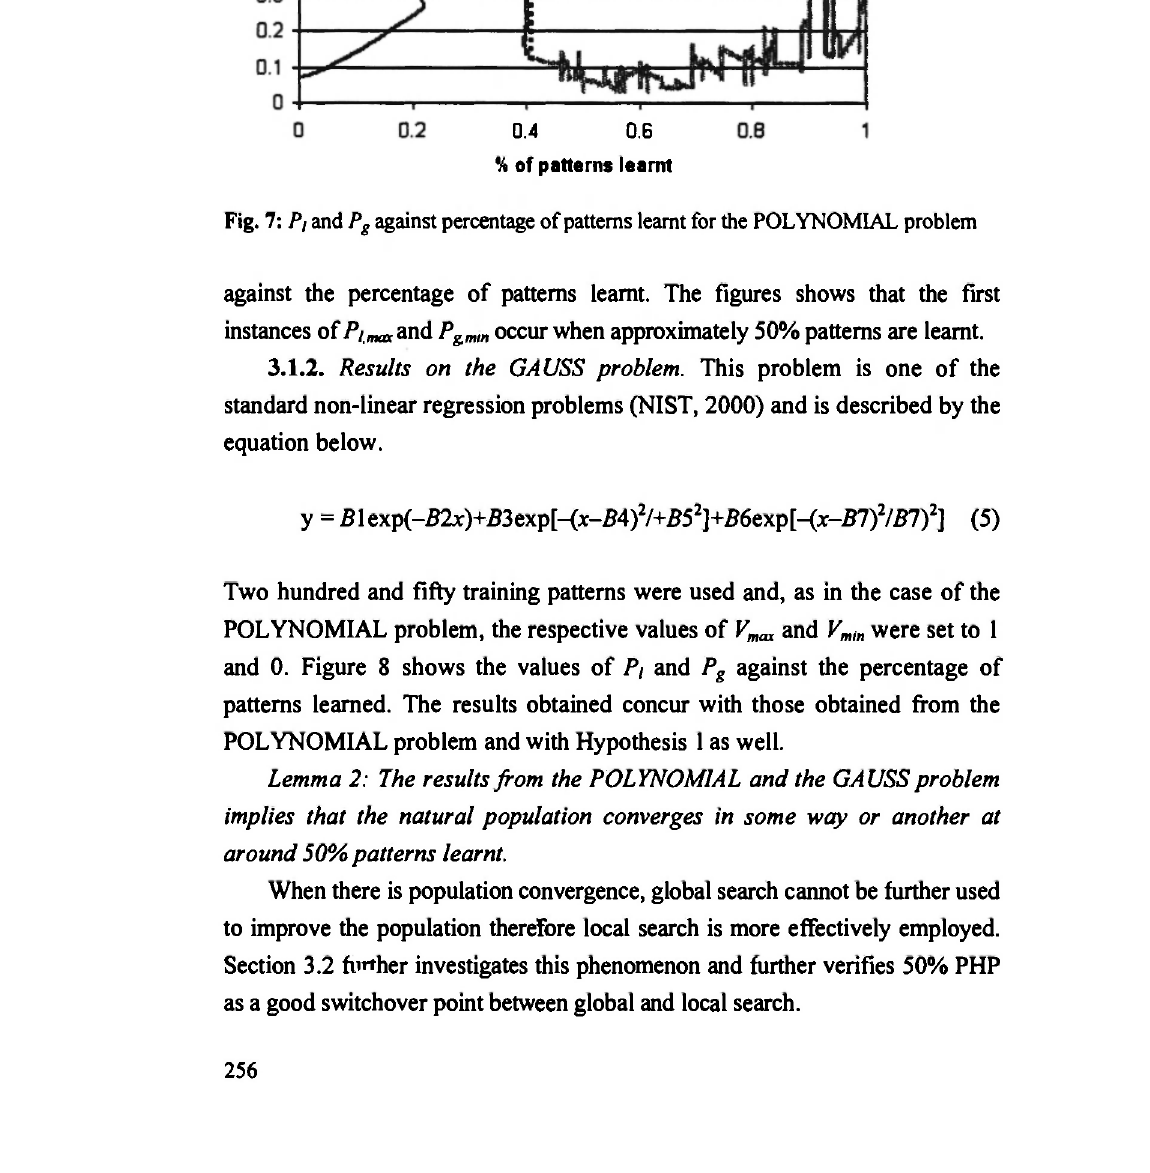
Fig. 7: P, and P g against percentage of patterns learnt for the POLYNOMIAL problem against the percentage of patterns learnt. The figures shows that the first instances of Λ.max and P Rmm occur when approximately 50% patterns are